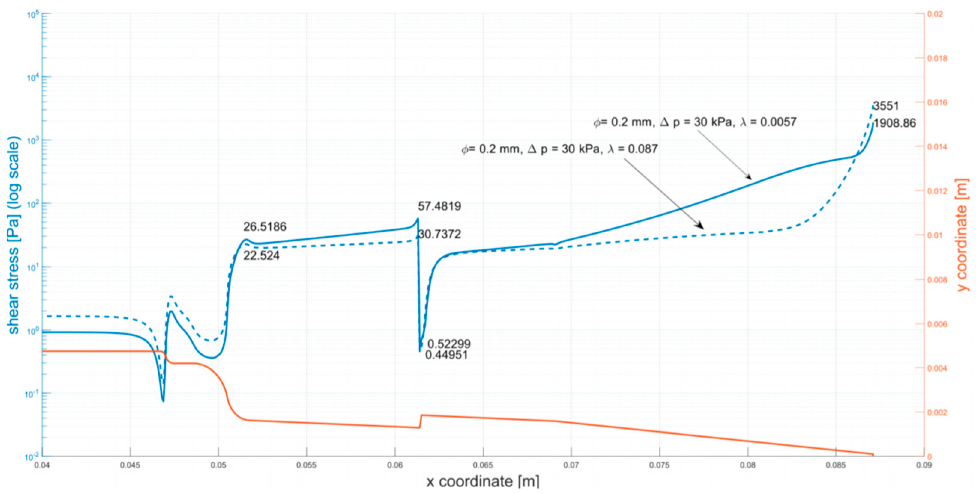
Figure A1. Shear stress at the walls of the cartridge ( φ = 0.2 mm, ∆ p = 30 kPa).